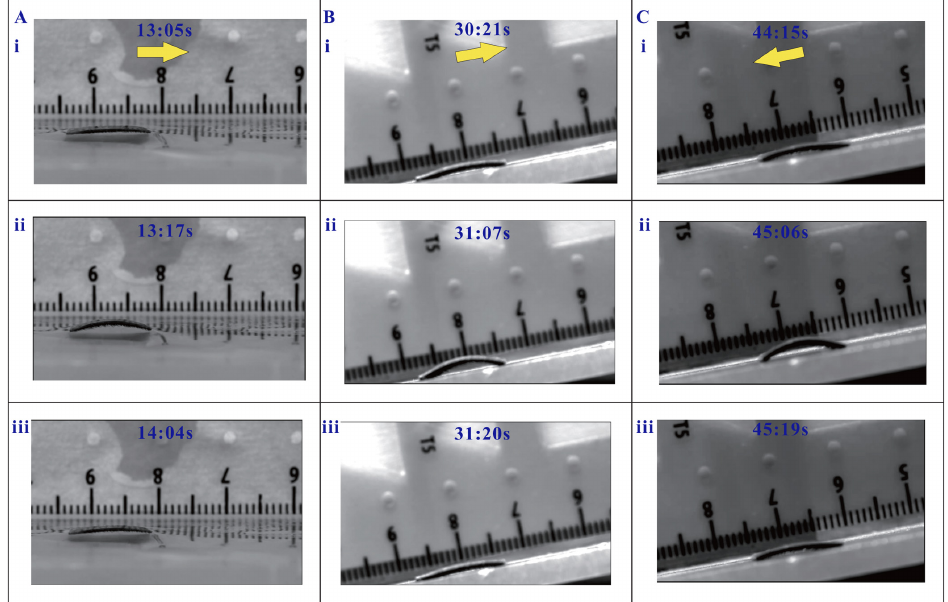
Figure 6. Locomotion test results of magnetic inchworm robot in special conditions. ( A ) Locomotion test in water with a level height of 1 mm. ( B ) Upward locomotion in an inclined plane with 10 ◦ inclination angle. ( C ) Downward locomotion in an inclined plane with 10 ◦ inclination angle. In each subfigure, the yellow arrow represents the movement direction. i, ii, and iii indicate the snapshots at different